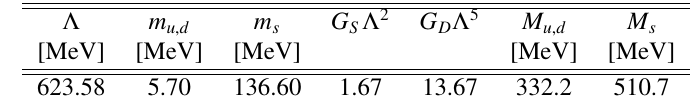
Table 1. Quark model parametrization. Λ represents the momentum cuto ff , m u , d , s are the quark current masses, G S and G D are coupling constants. Furthermore, the vacuum constituent quark masses, M u , d and M s , are also